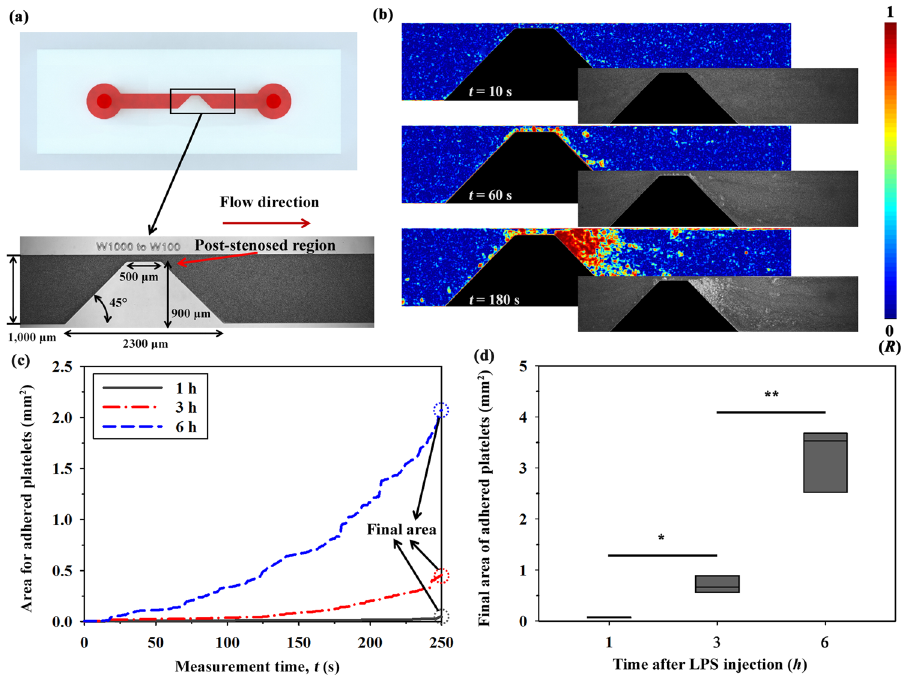
Figure 4. Estimation of platelet adhesion using a stenosed microchannel. ( a ) Schematic and optical image of the region of interest (ROI) of the stenosed microchannel. The severity of the stenosed channel is 90%. ( b ) Correlation maps depicting 2D correlation coefficient ( R ) in ROI after delivering blood samples at 6 h from LPS injection into the stenosed microchannel. Corresponding optical images are included for comparison. ( c ) Temporal variations in the area of the adhered platelet aggregates according to the lapsed time after LPS injection. ( d ) Comparison of the final area of adhered platelets at 250 s according to the lapsed time after LPS injection. ( * p < 0.005 and ** p < 0.001: significant difference between